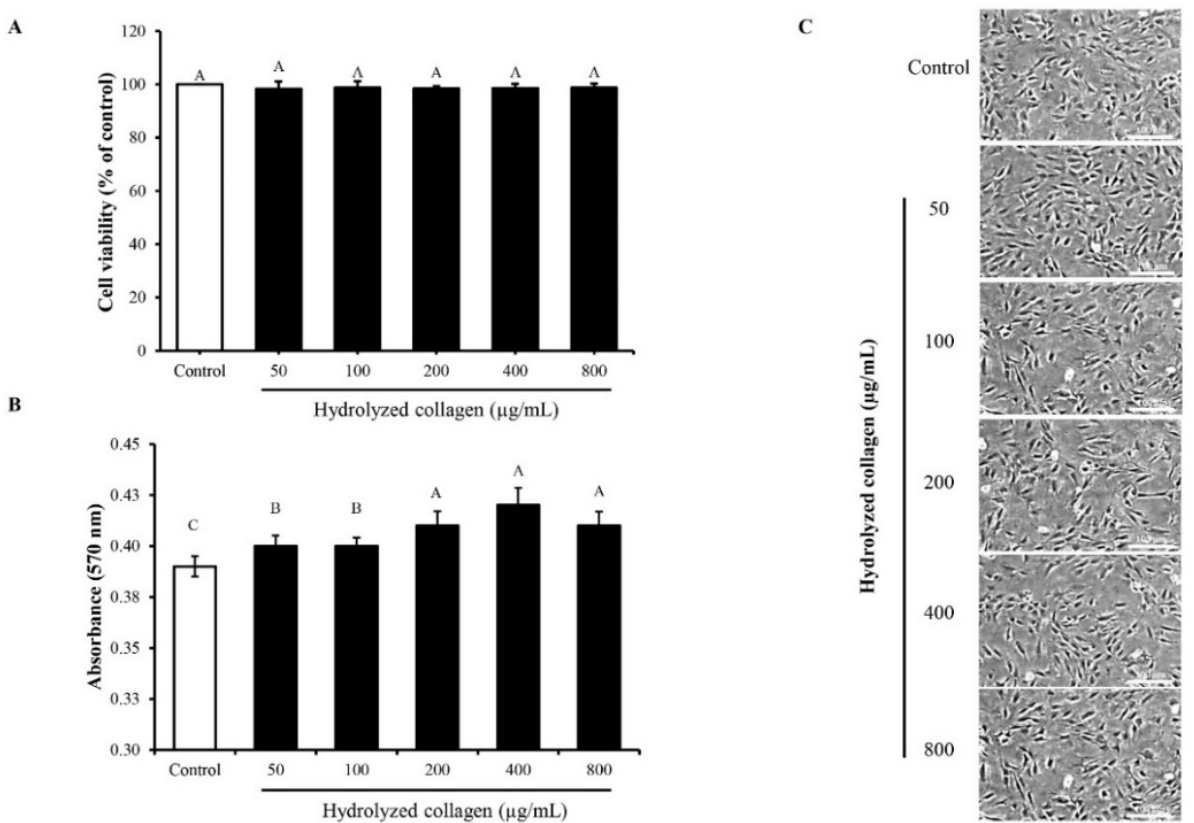
Figure 2. Effect of defatted sea bass skin hydrolyzed collagen (HC) dissolved in α -MEM medium with 10% FBS ( A ) or 1% FBS ( B ) at various concentrations on proliferation of MC3T3-E1 pre-osteoblast cells. Cell morphology using scale bar of 100 µm and magnification of ×10 ( C ) after treatment with HC at various concentrations in the presence of 10% FBS. Incubation time of 24 h was used. Error bars represent standard deviation ( n = 3). Different letters on bars indicate significant differences ( p < 0.05).